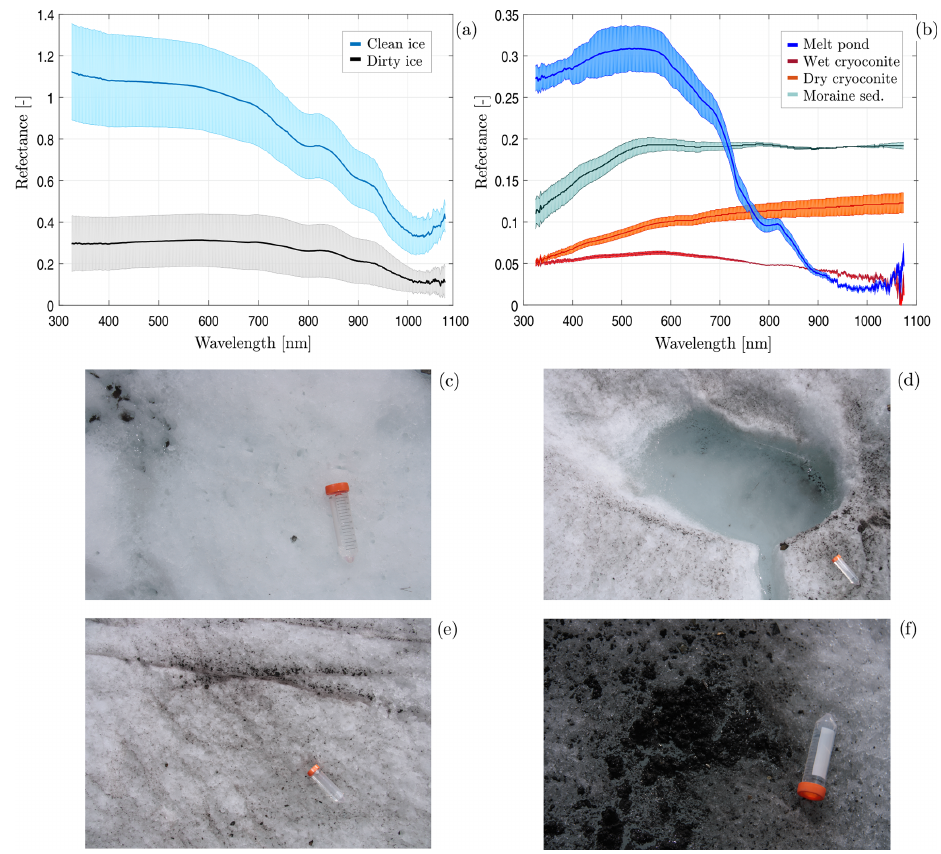
Figure 2. Mean and standard deviation of the reflectance spectra acquired on the glacier ablation zone with the FieldSpec ASD: (a) clean and dirty ice (picture in c, e ) reflectance spectra; (b) melt pond and wet cryoconite (picture in d, f ), dry cryoconite and moraine sediment reflectance spectra (the last two classes were measured in the laboratory). Mean and standard deviation were computed on three samples for each